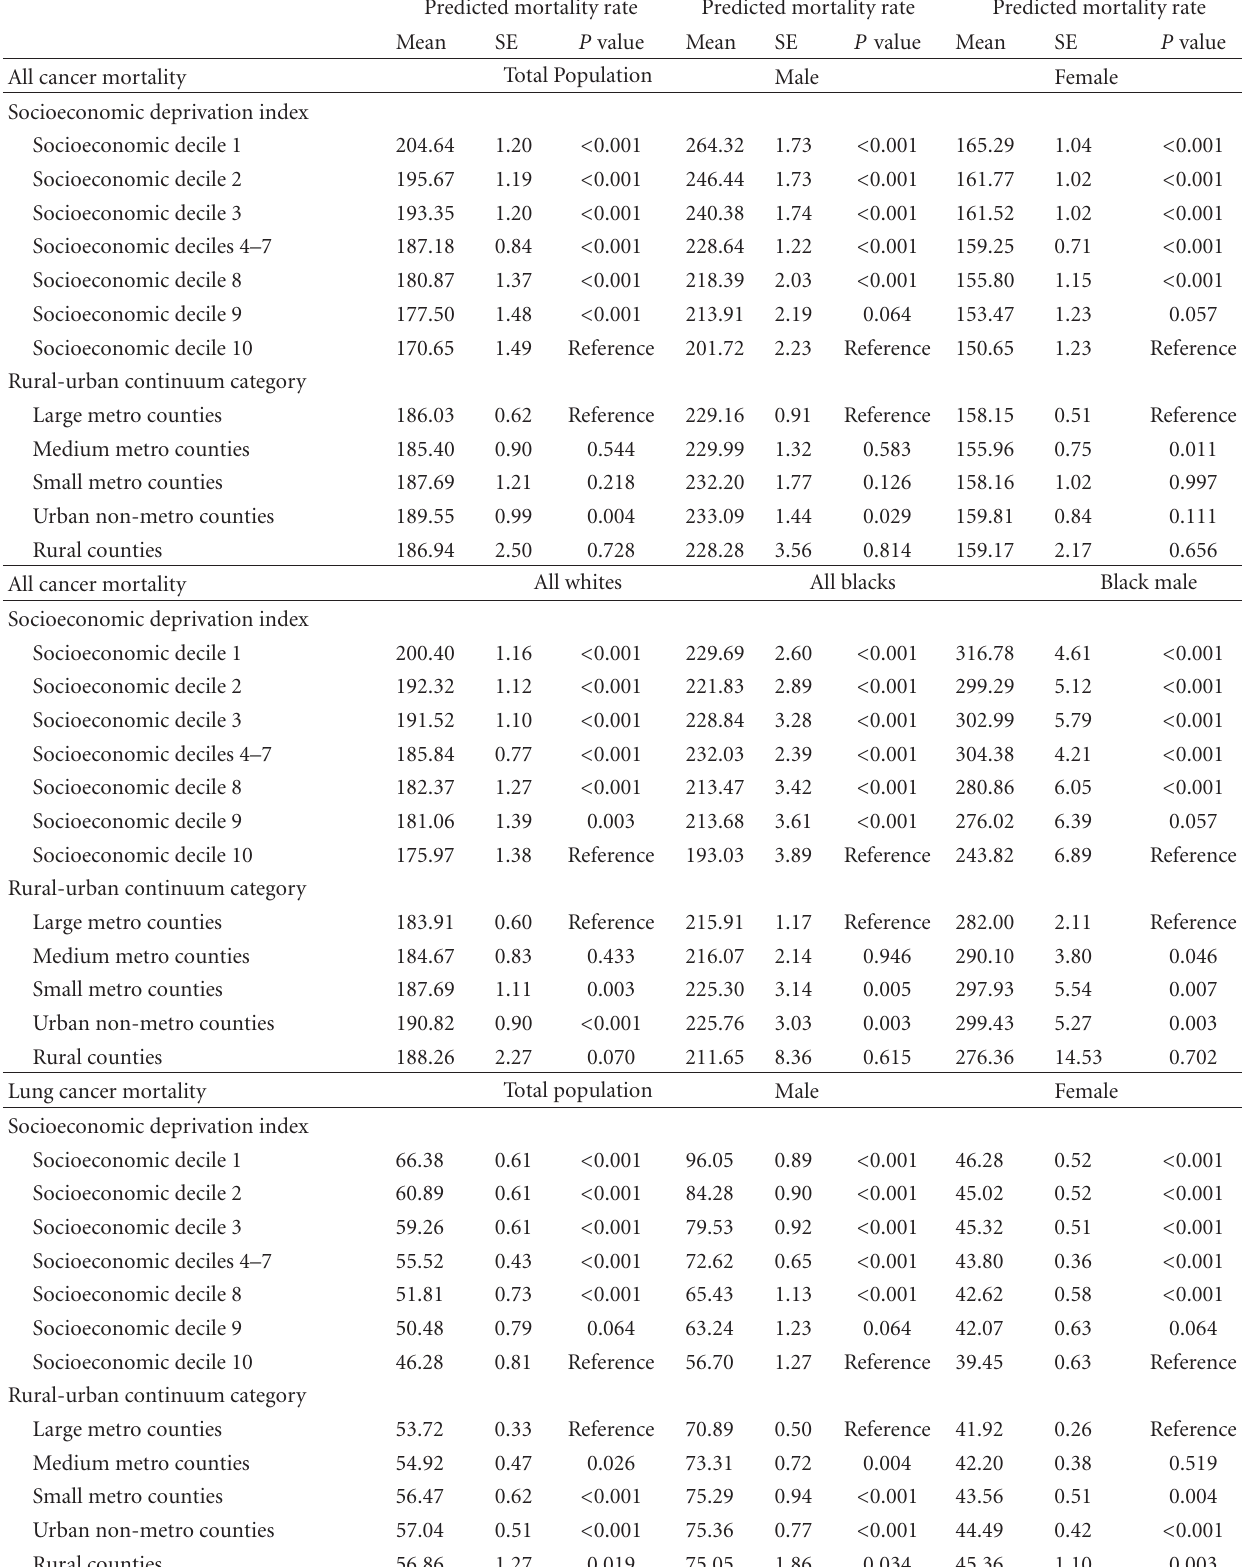
Table 2: Multivariate weighted least squares regression models showing adjusted di ff erentials in all-cancer and lung cancer mortality